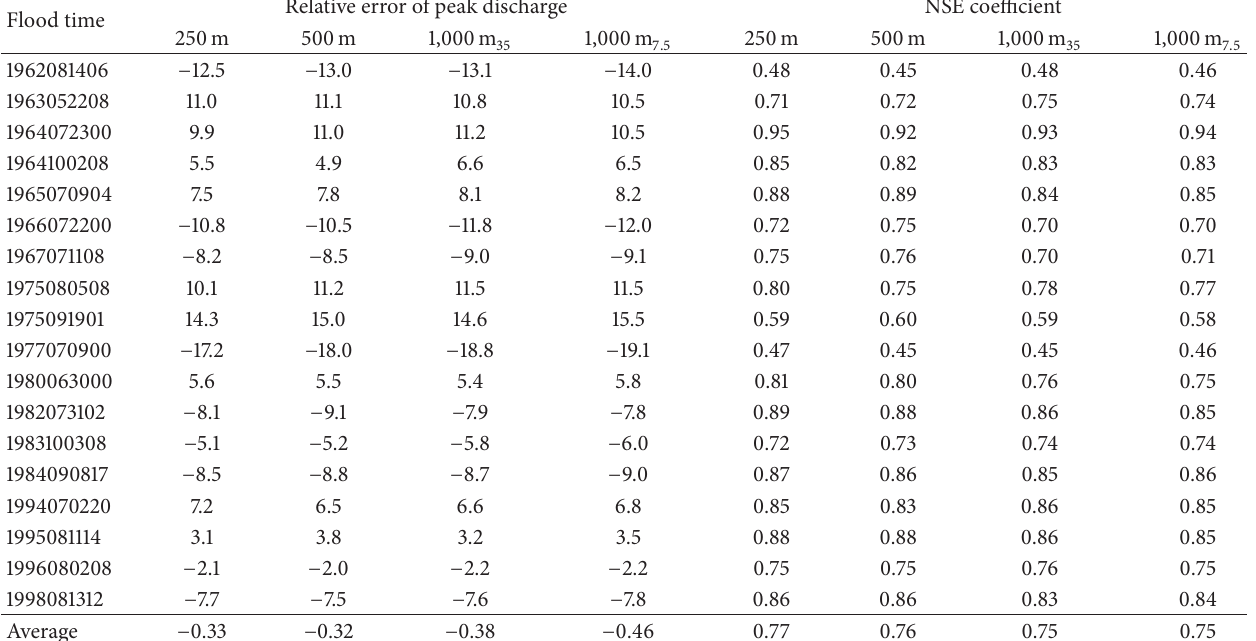
Table 5: Comparison results under different DEM resolutions and channel thresholds.